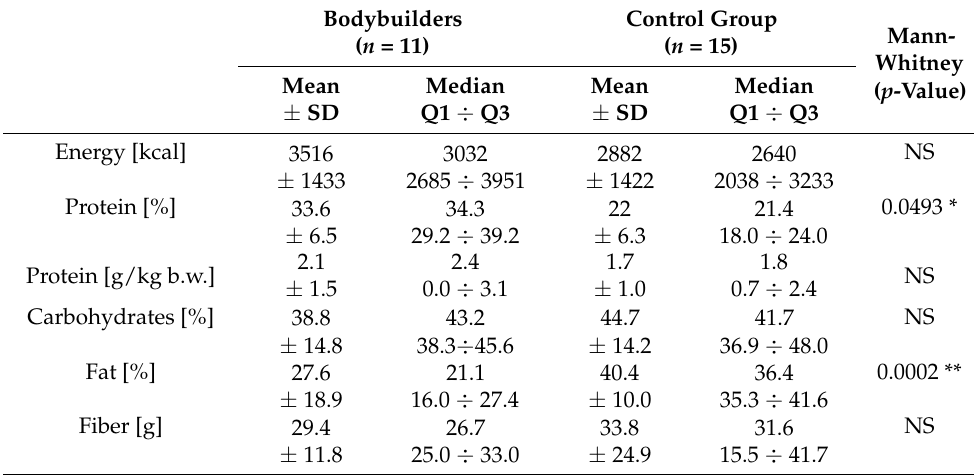
Table 5. Comparison of daily intake of energy [kcal], protein [%; g/kg b.w.], carbohydrates [%], fats [%], and fiber [g] of bodybuilders and the control group.